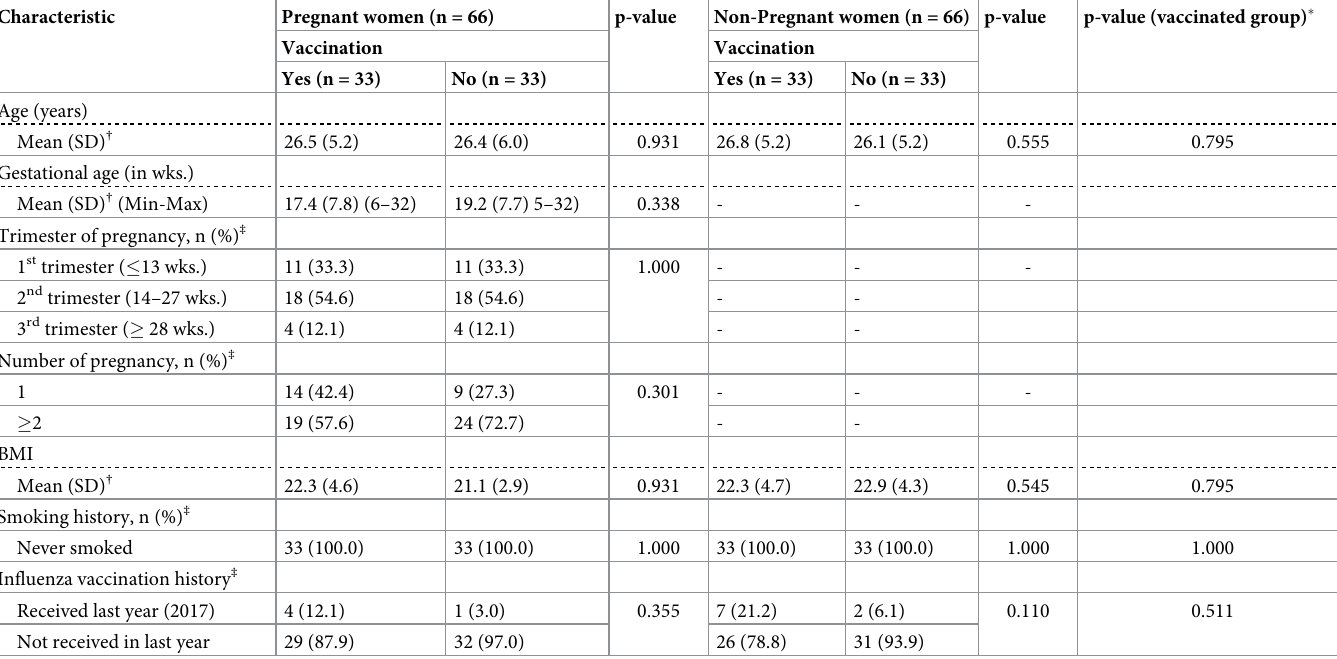
Table 1. Baseline characteristics of study participants (N =